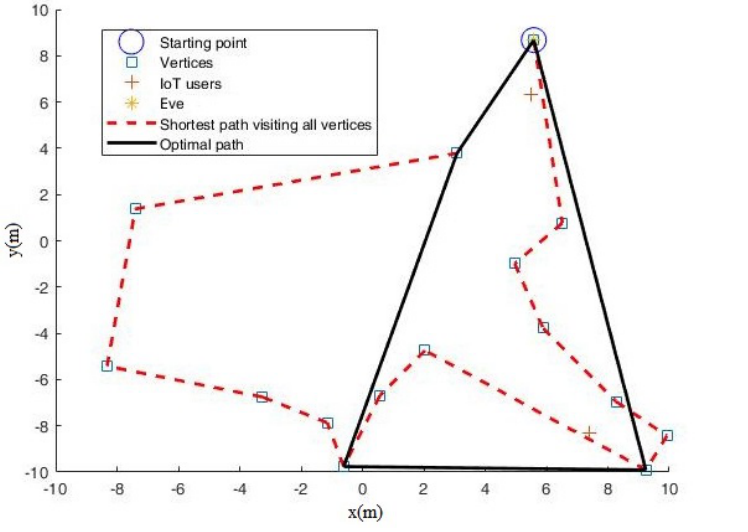
Figure 5. path for mobile relay with M = 15 when noise power σ 2 e = − 60